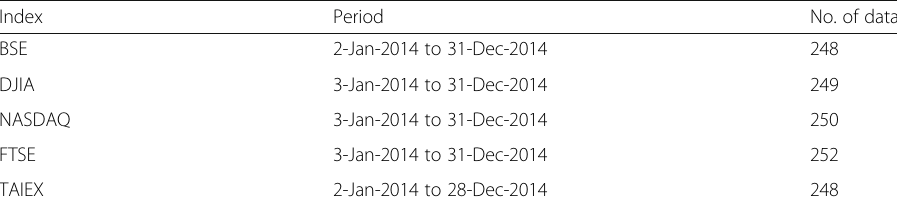
Table 1 Stock Indices (daily closing price) considered for